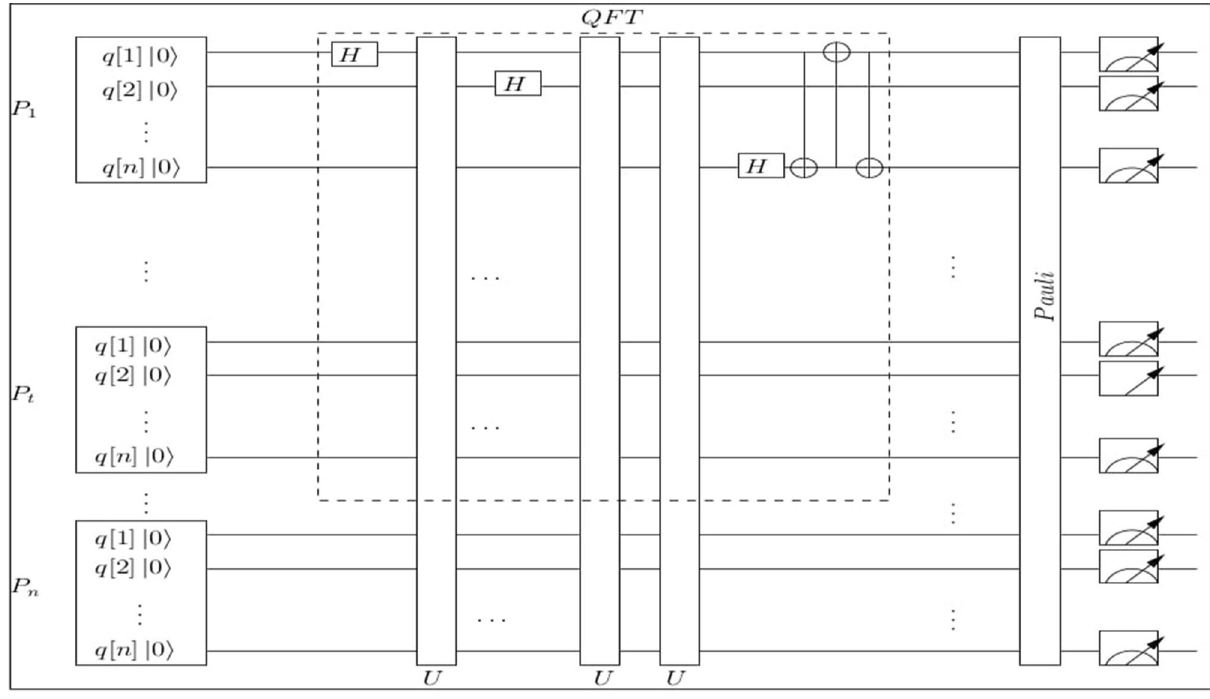
Figure 1. Circuit diagram of